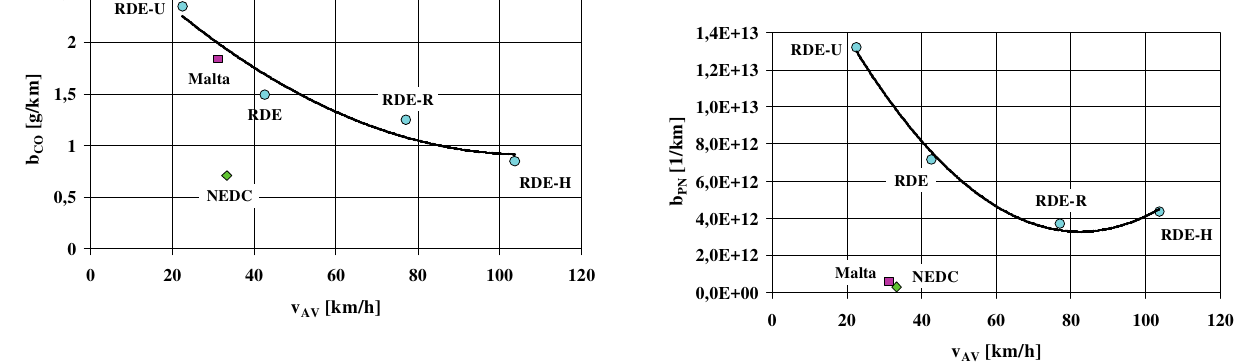
Fig. 16. The relation between the mean road emission of carbon monoxide – b CO and the mean vehicle speed – v AV in each test cycle